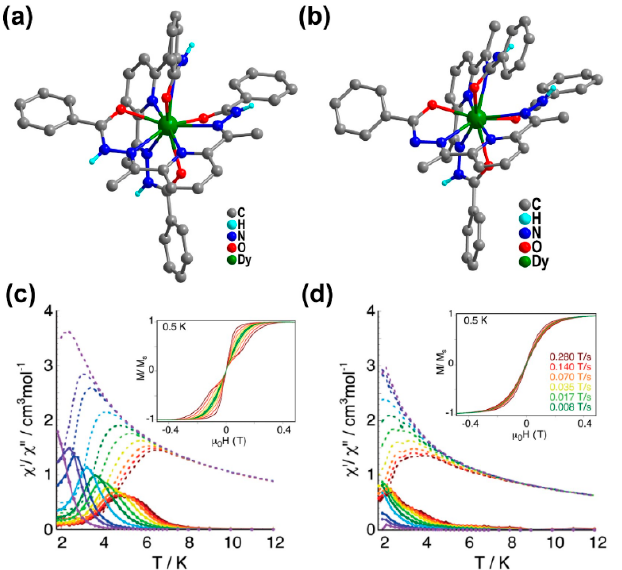
Figure 5. ( a , b ) Structures of the cationic part of 1 and 2 ; ( c , d ) Temperature dependence of χ′ M (dotted lines) and χ″ M (solid lines) of 1 and 2 under 1000 Oe applied DC field at frequencies from 1 to 1200 Hz (Inset: hysteresis loops taken at 0.5 K and at variable scan rates). Figures and captions are reproduced from Reference [38] with permission from the Royal Society of Chemistry.